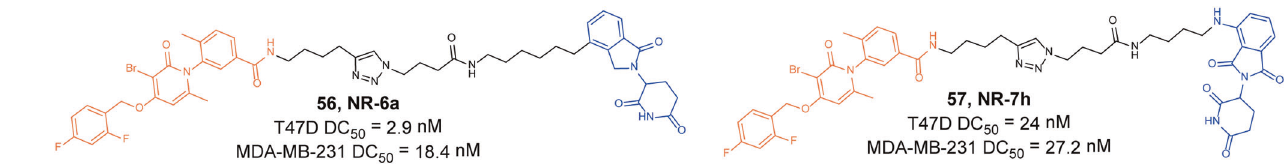
Fig. 15 The representative PROTACs targeting